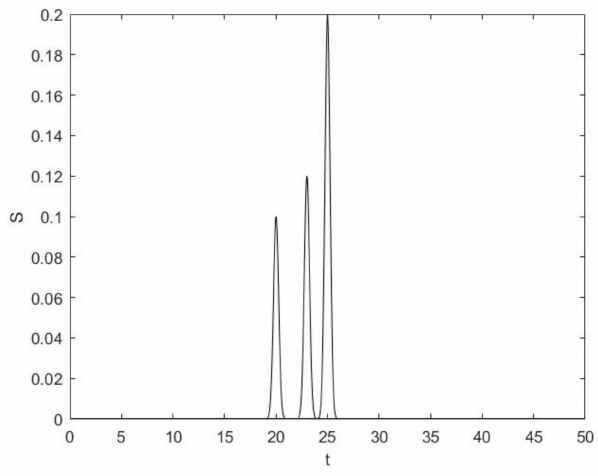
Figure 3. Main pulse with three microbursts measured in a particular frequency